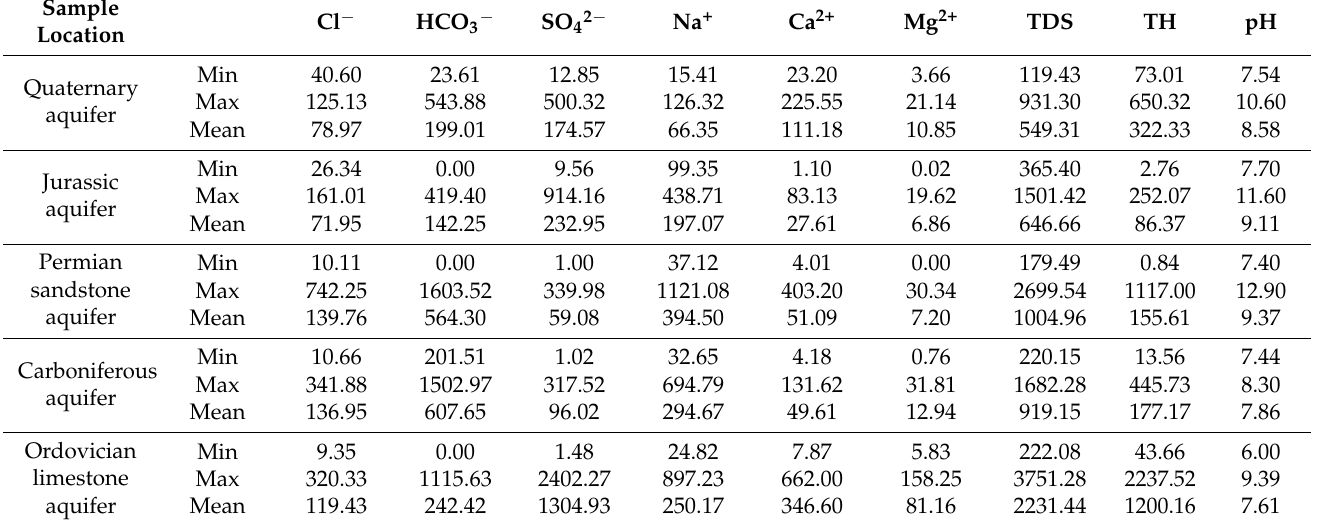
Table 2. Water quality testing parameters of each aquifer in the Dongtan Coal Mine (except for pH, units of other parameter are mg · L − 1